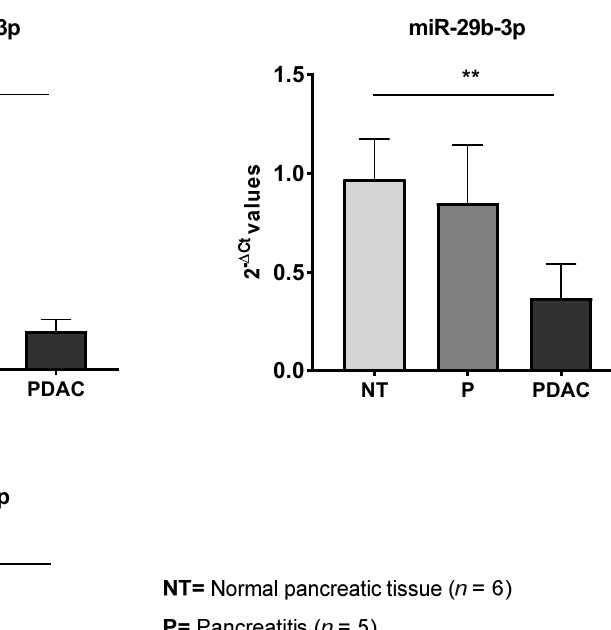
Table 3. Comparison of the levels of the miRNAs in PDAC, NT, and P. p -Values refer to Kruskal–Wallis test followed by pairwise comparisons. FR (fold regulation); ns (statistically not significant).